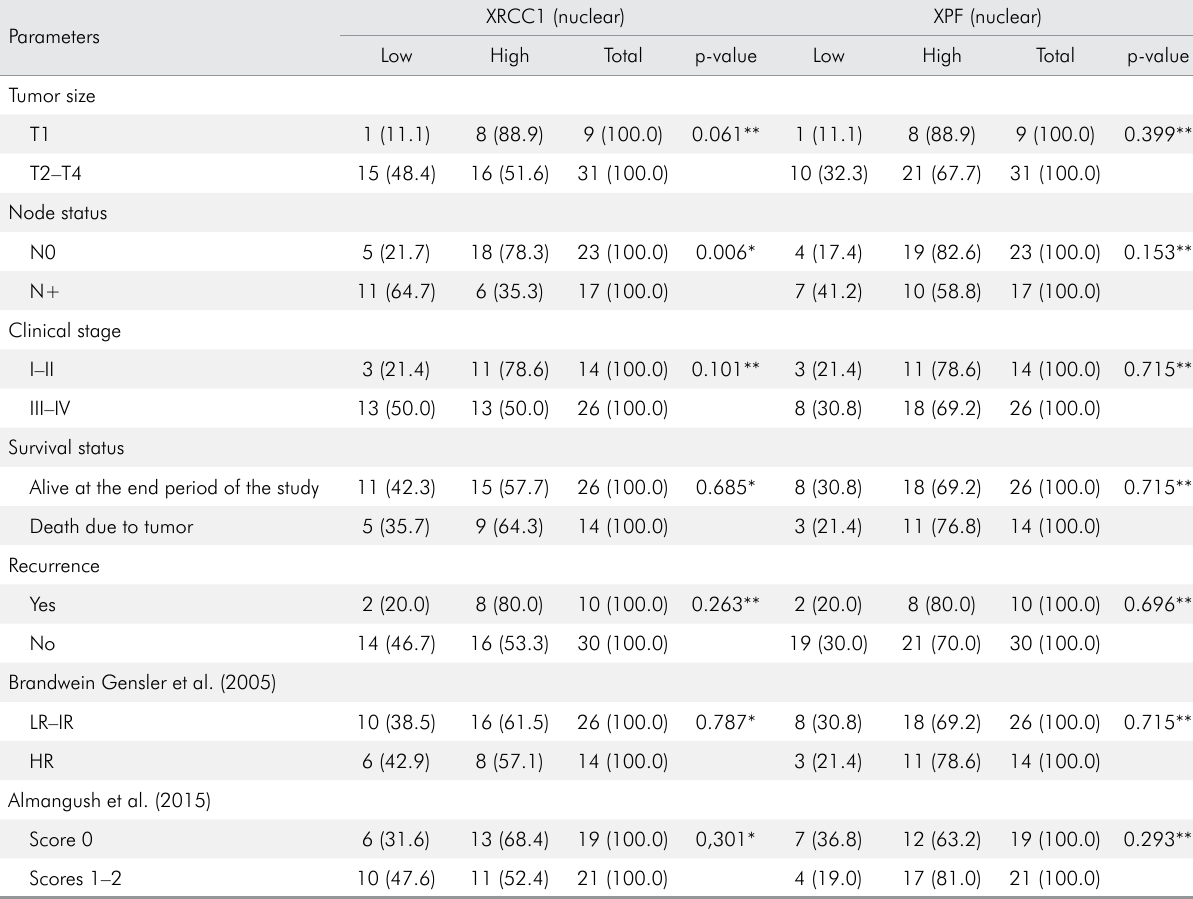
Table 2. XRCC1 and XPF nuclear expression in relation to clinicopathological findings of oral tongue squamous cell carcinoma.